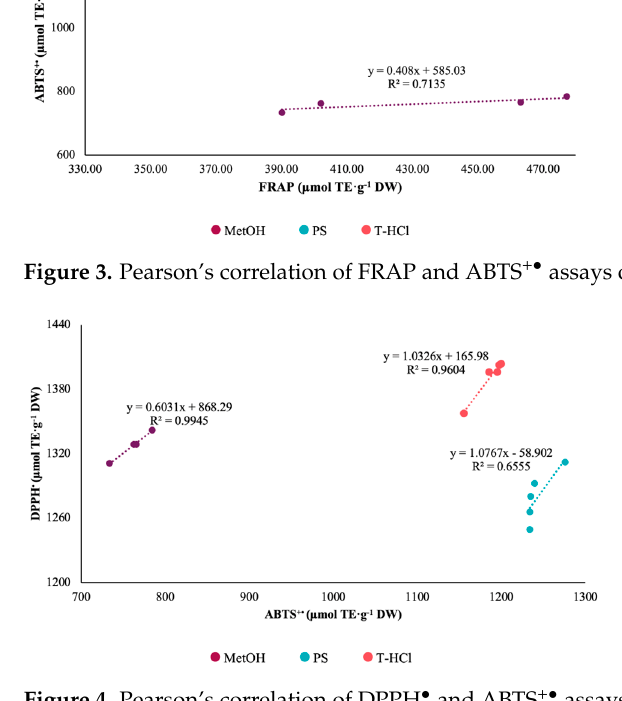
Figure 4. Pearson’s correlation of DPPH • and ABTS +• assays of MetOH, PS, and T-HCl extracts.